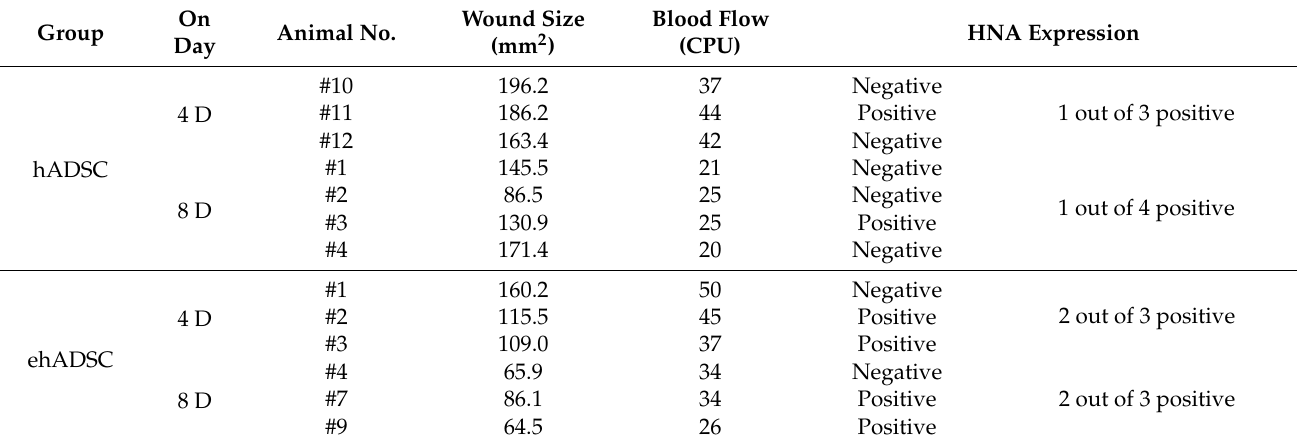
Figure 7. Observation of HNA-positive cells. Representative images of HNA-positive cells are shown at both 4 and 8 days after transplantation. Table 1. Summary of outcomes in each animals with ADSC transplantation.